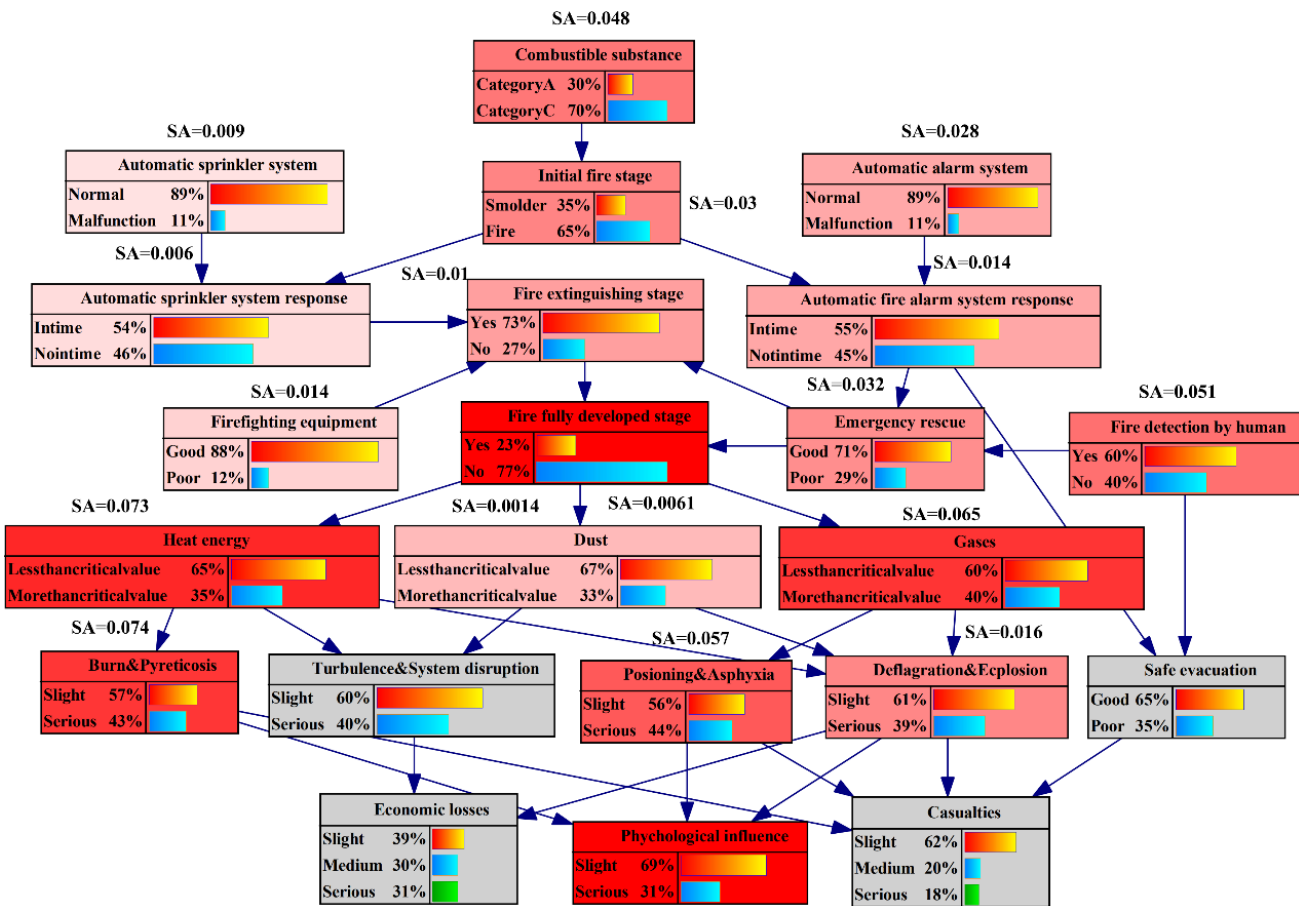
Figure 9. The sensitivity analysis of psychological influence.